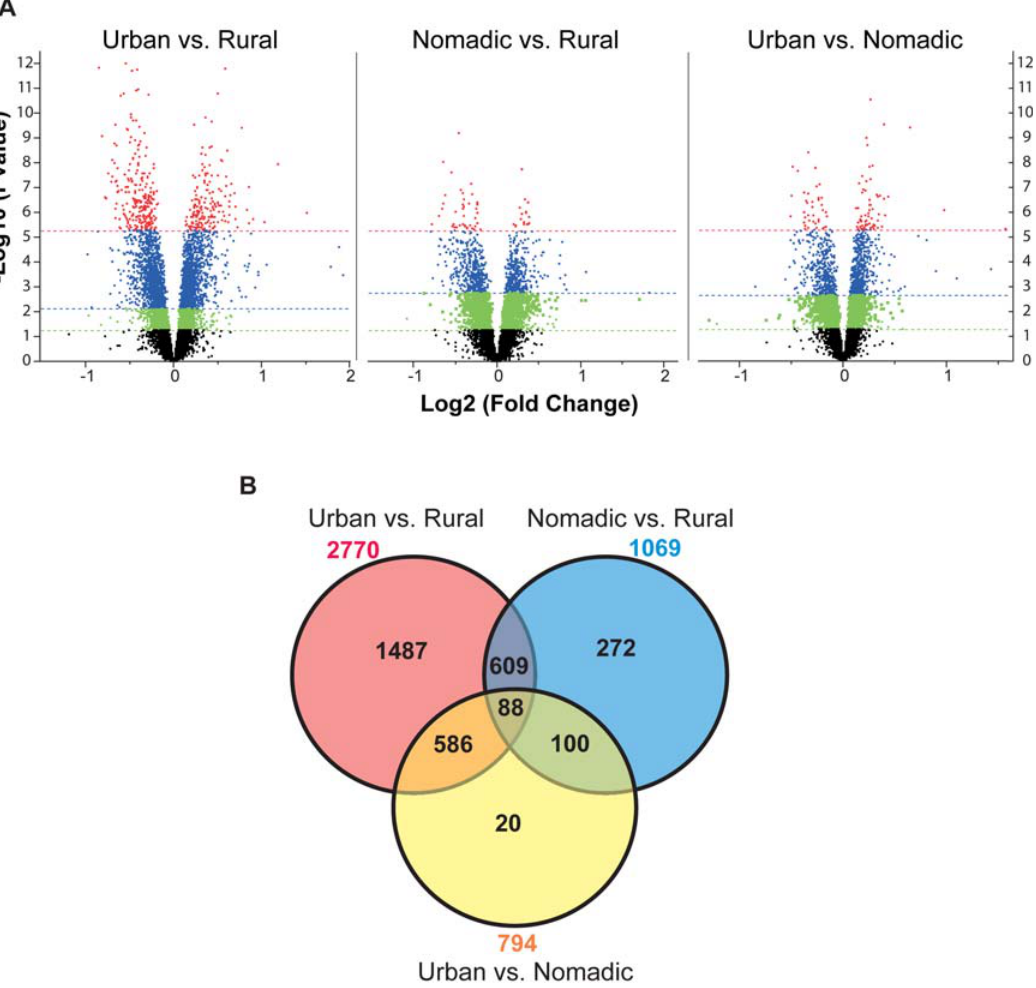
Figure 2. Volcano plots of statistical significance versus magnitude of differential expression between locations. (A) For each transcript, significance is shown as the negative logarithm of the P value on the y-axis, and the log base 2 of magnitude of mean expression difference is on the x-axis. Dashed lines indicate the threshold for significance (green: P , 0.05, blue: 1% FDR, and red: Bonferroni adjusted P , 0.05). The Venn diagram (B) shows the numbers of differentially expressed genes at 1% FDR for each comparison and the overlaps between